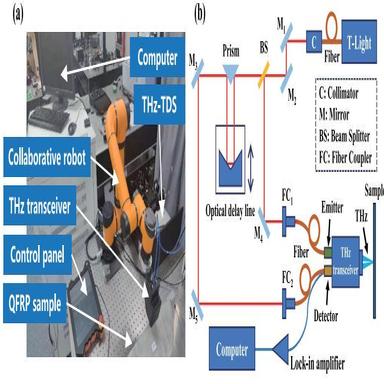
(a) The detection environment of improved THz-TDS with a collaborative robot. (b) Schematic diagram of the THz-TDS optical path.